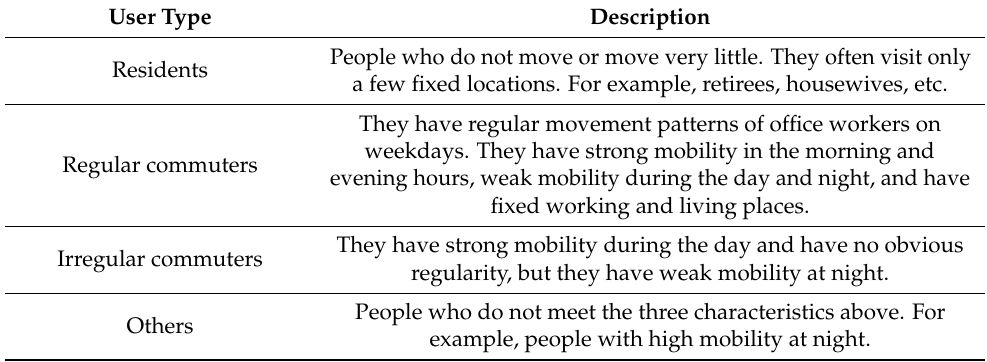
Table 1. User types and characteristics.